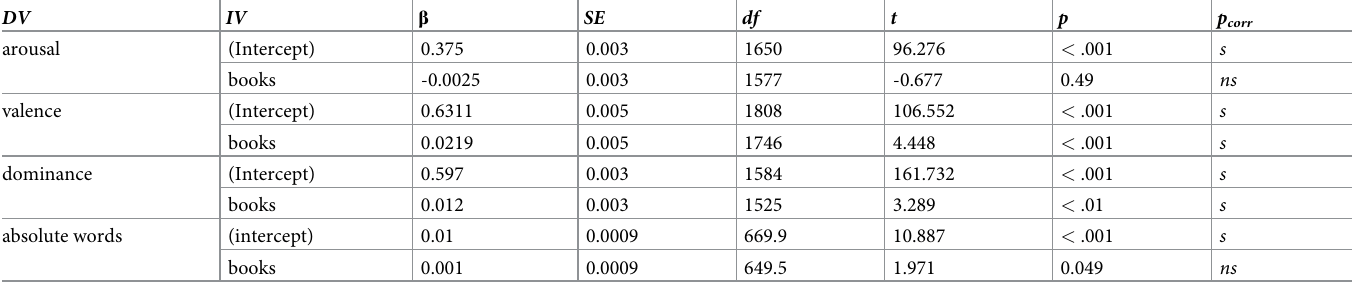
Table 5. Results of mixed linear models for absolute words, valence, arousal, and dominance regressed on genre (book related subreddit vs non-book-related sub- reddit) for Study 4.